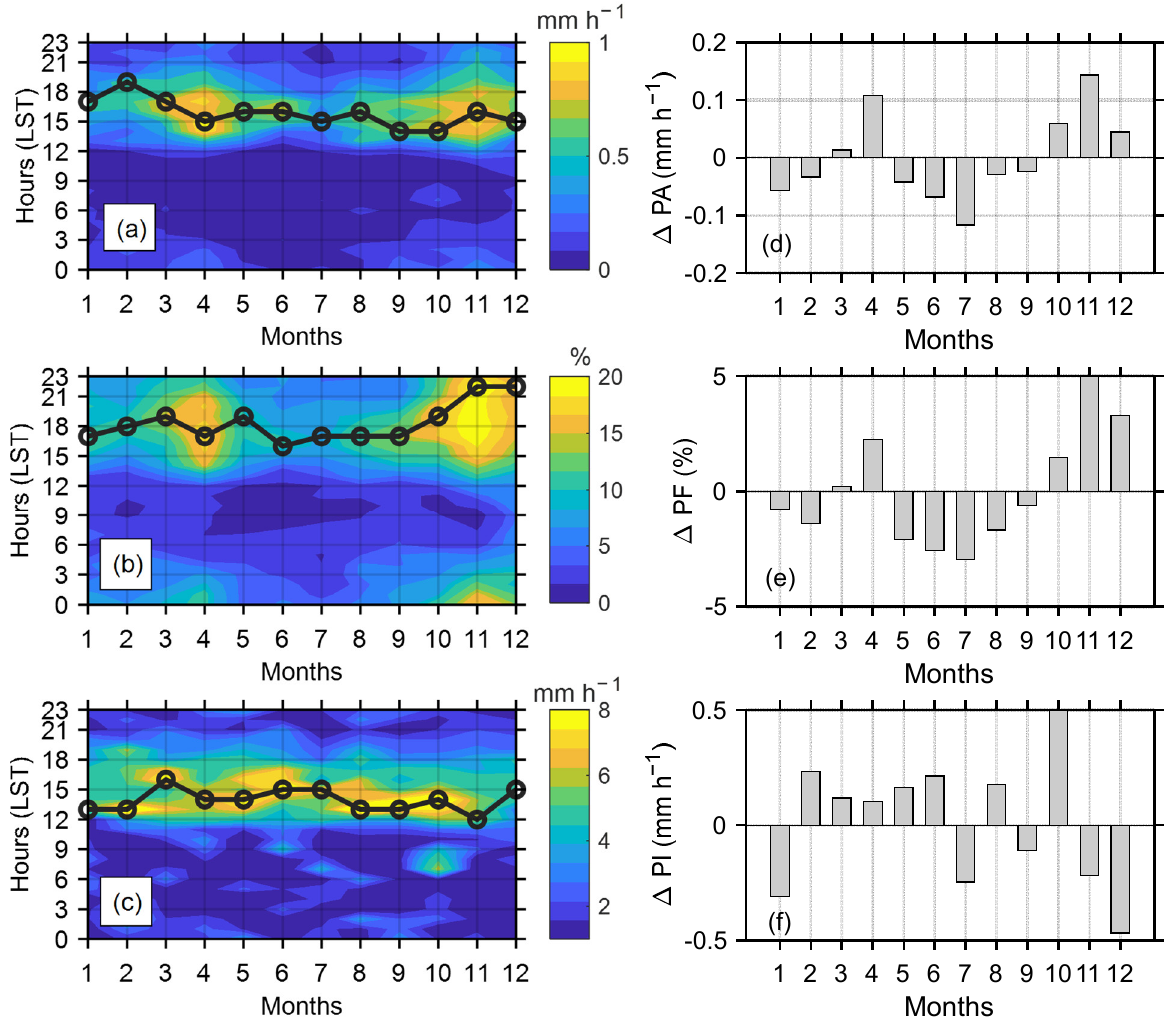
Figure 6. Monthly variations in diurnal cycles of PA ( a ), PF ( b ), and PI ( c ), as well as their differences (Δ) with average climatological values ( d−f ) described in Section 3.1. Lines with circle markers indicate the peak times of PA ( a ), PF ( b ), and PI ( c ).